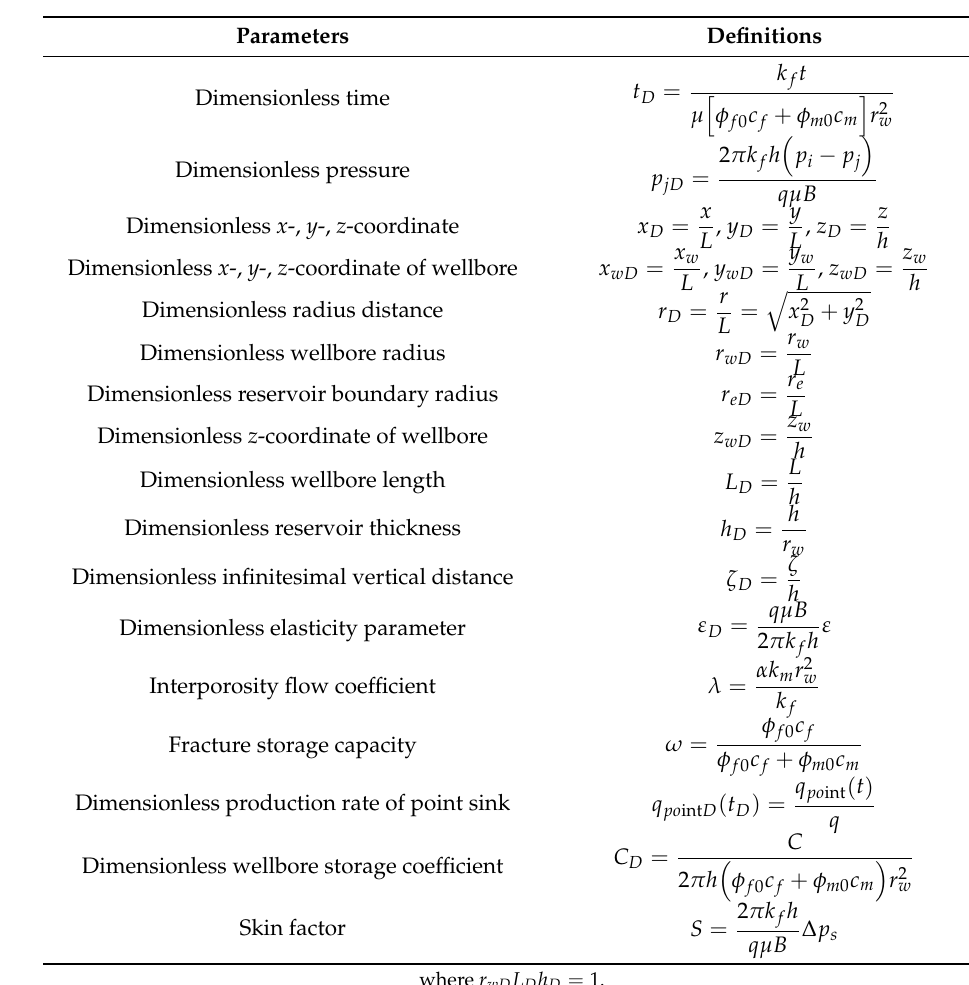
Table 1. Definitions of dimensionless